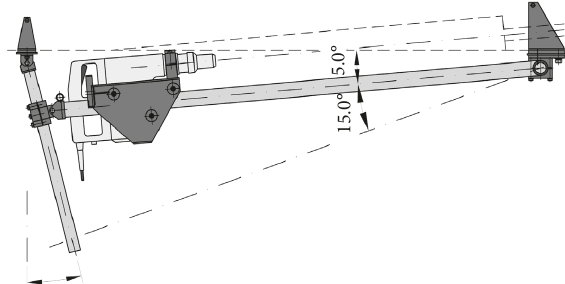
Figure 2: Scheme of the drilling support for drilling substitute cable ducts of relatively small diameters ( ϕ � 35 ∼ 52 mm) into the concrete of the existing bridge structure. It allows adjustment of both vertical and horizontal drilling angles. The picture shows a support fitted with a drill using the impact technology.